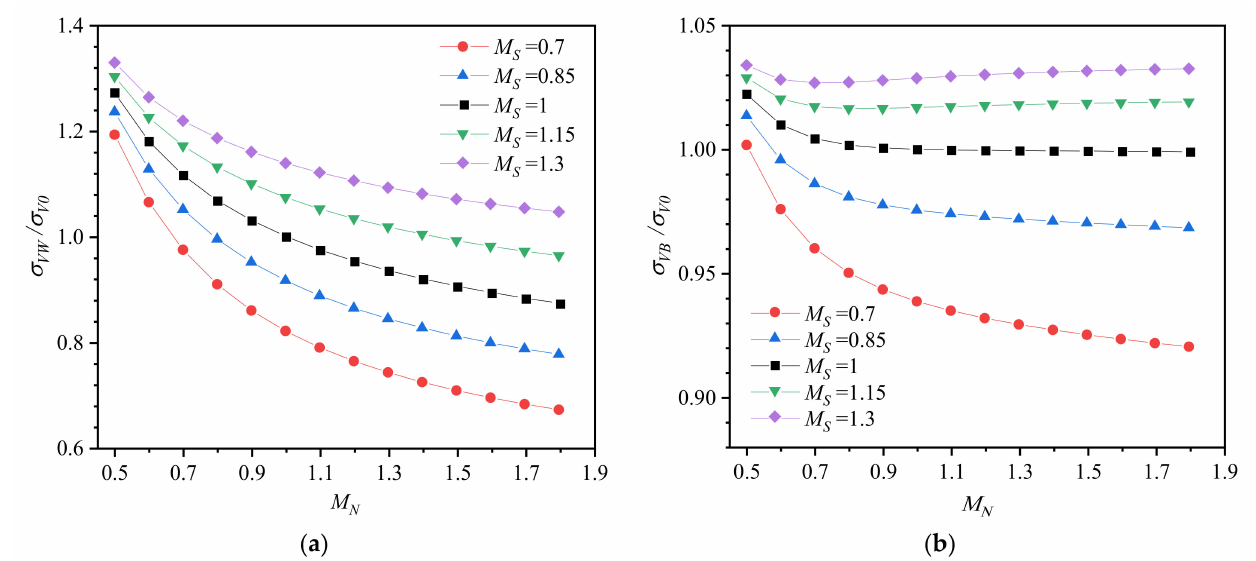
Figure 6. Von Mises stress. ( a ) Weld metal and ( b ) base metal.